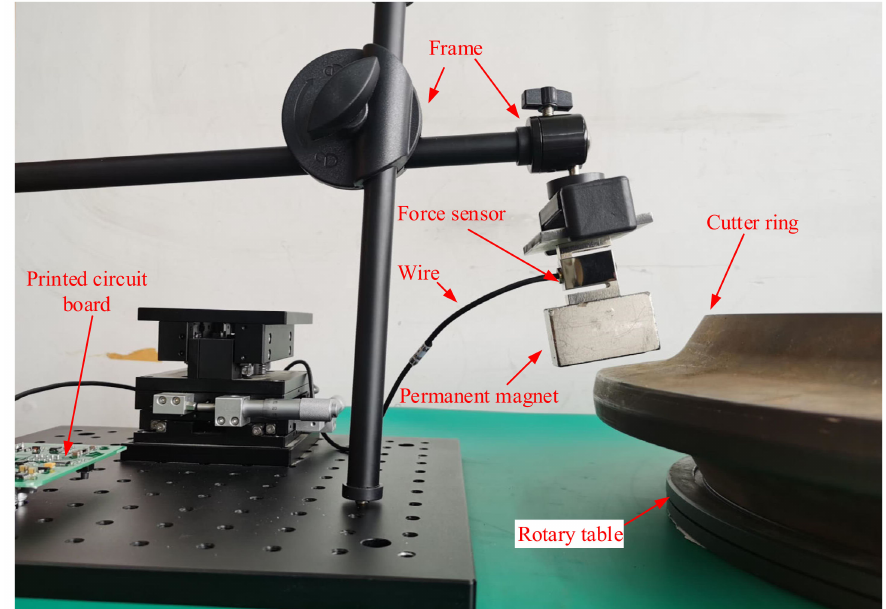
Figure 9. Experimental testing on the wear detection.